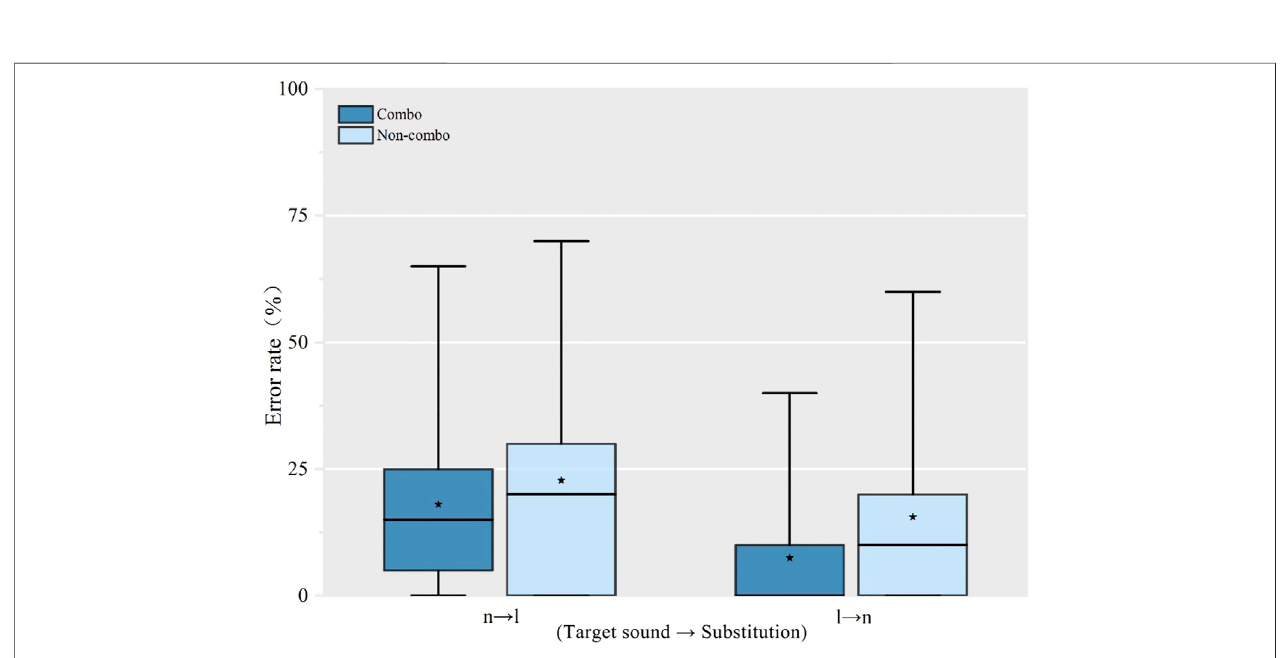
FIGURE 5 | Error rate of production of Standard Mandarin disyllabic words by formation.